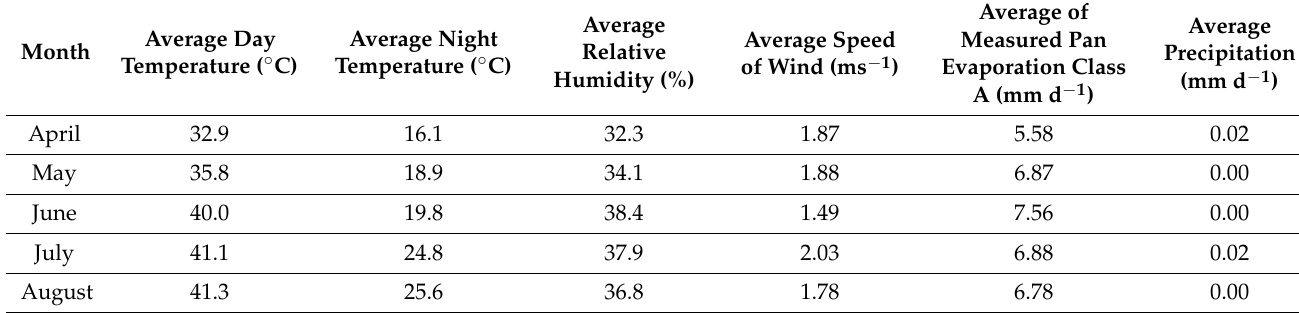
Table 1. Average weather data for the Fayoum region, Egypt, over the sweet potato growing seasons.